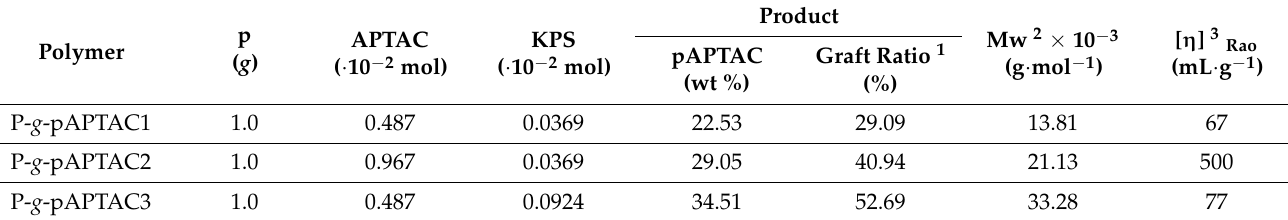
Figure 1. General chemical structure of polycations based on pullulan P- g -pAPTAC. Table 1. Synthesis parameters of pullulan derivatives P- g -pAPTAC [25].